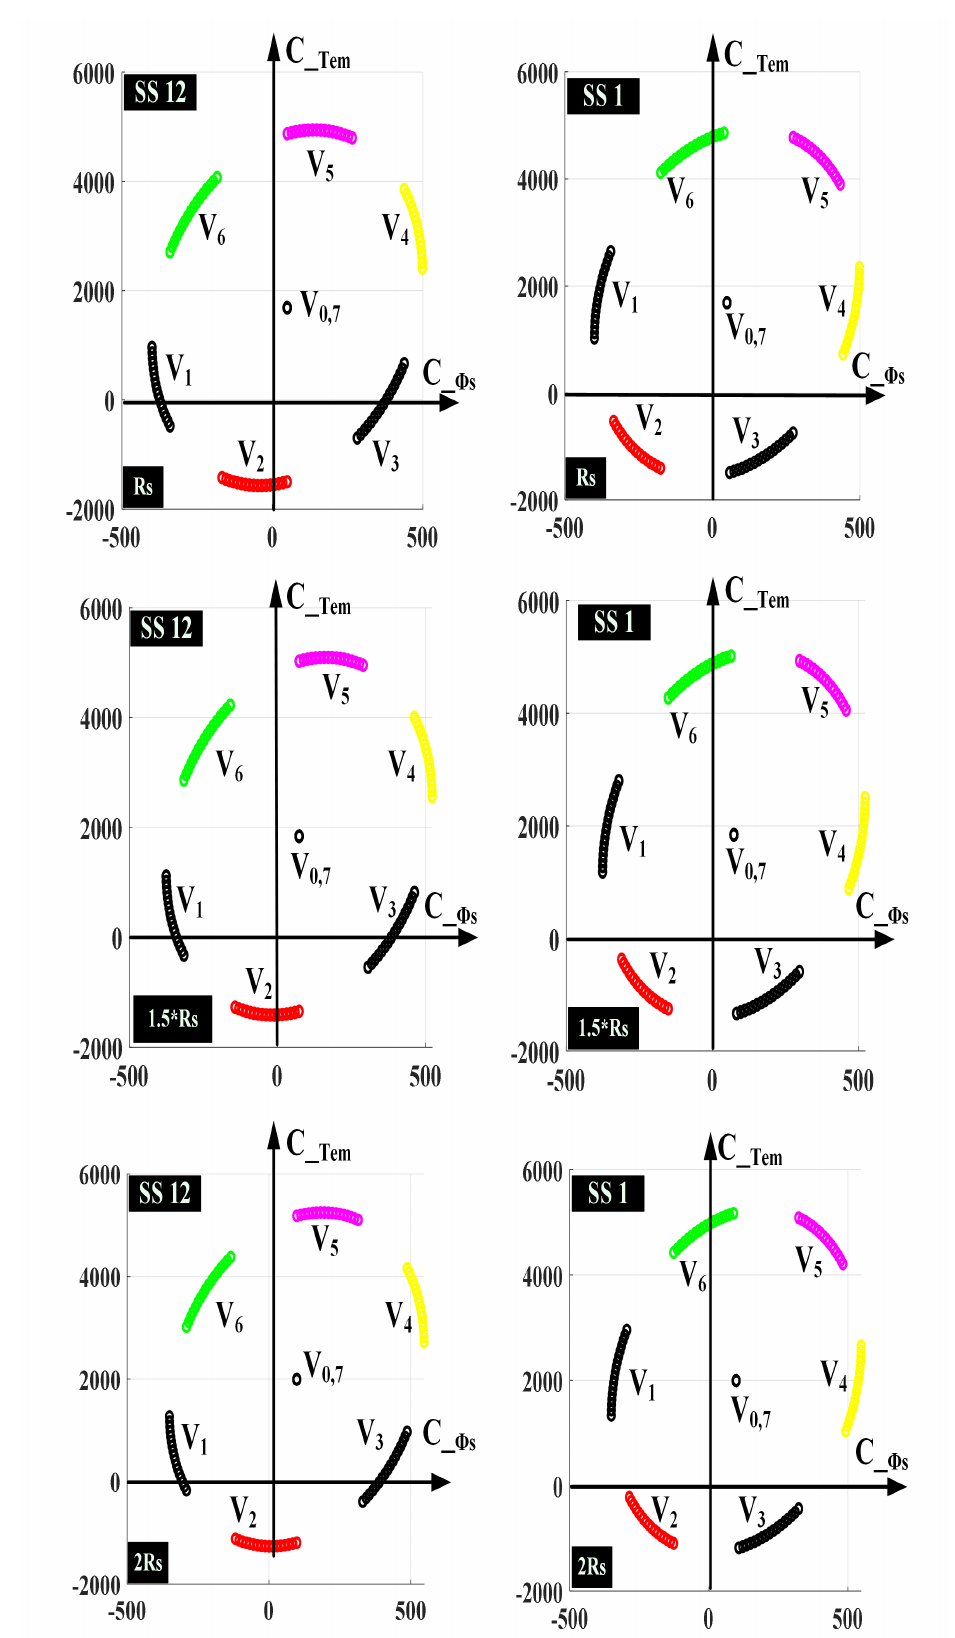
Figure 6. Effect of the voltage vectors on the error variation of both torque and stator flux for Rs